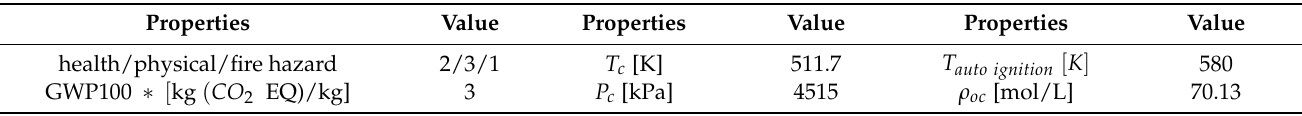
Table 3. Cyclopentane specifications as ORC working fluid (Reprinted with permission from